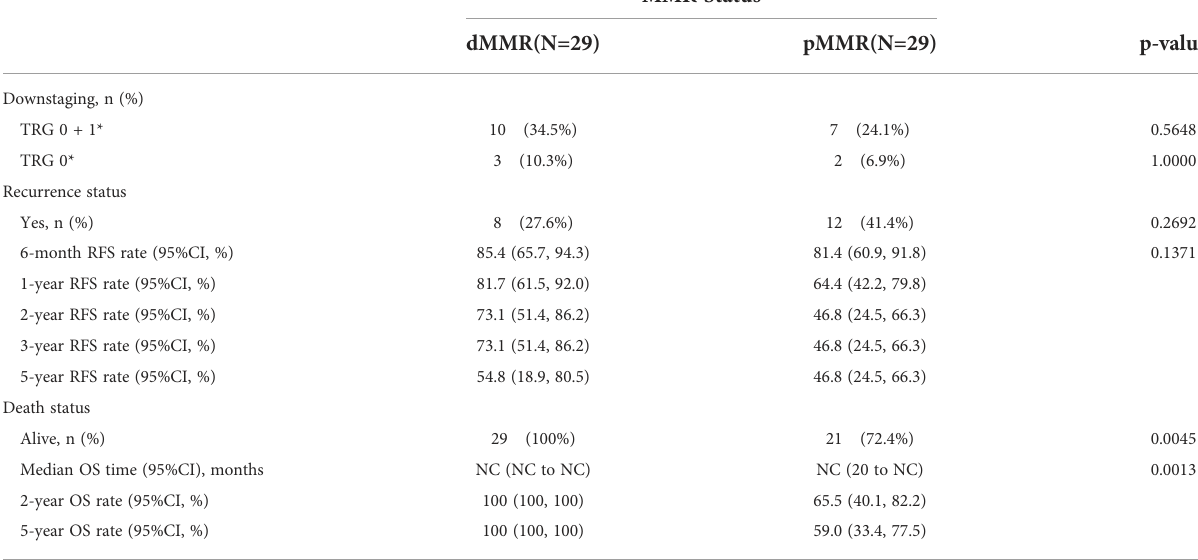
TABLE 4 Downstaging, recurrence and overall survival endpoints of the 58 matched MMR patients.